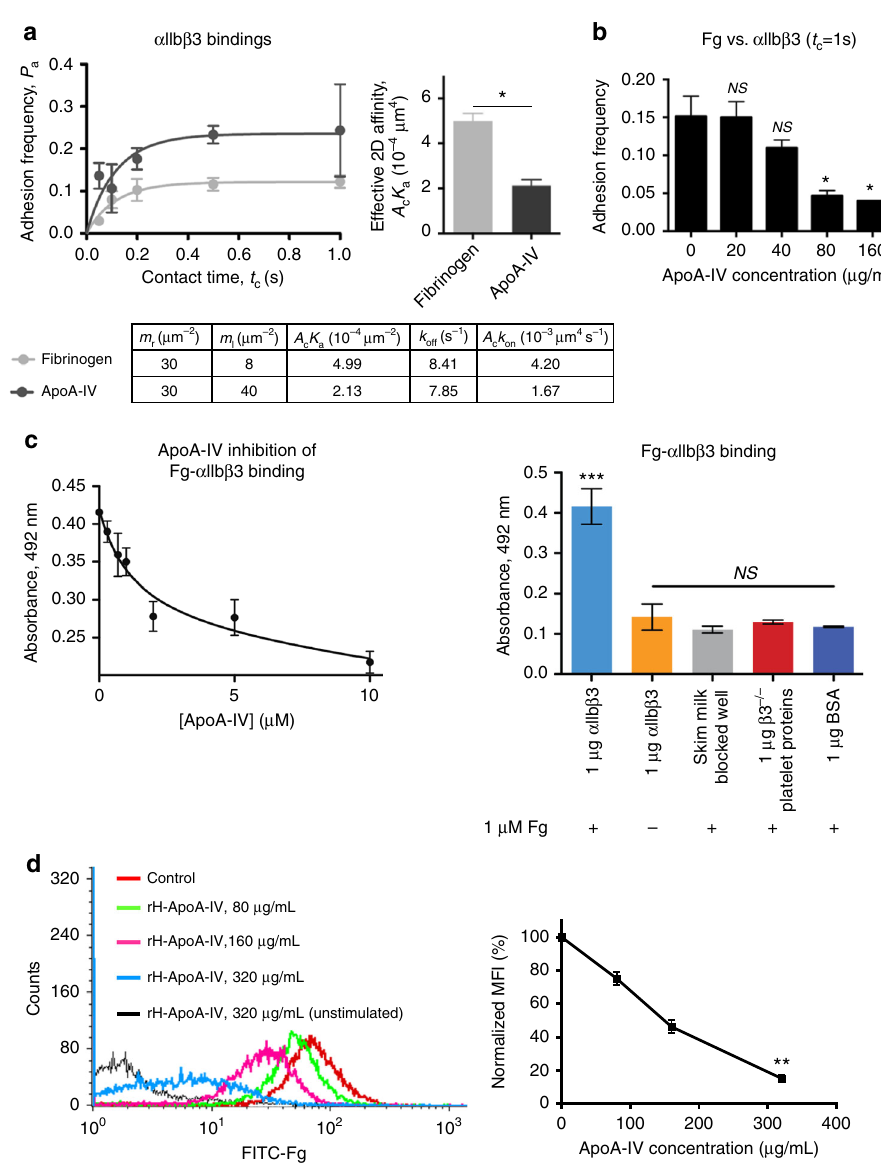
Fig. 2 ApoA-IV competes with Fg binding to α IIb β 3 integrin. a Effective 2D af fi nity of apoA-IV- α IIb β 3 versus Fg- α IIb β 3 within contact area. The adhesion frequency ( P a ) depends on the densities of receptor and ligand, therefore the weaker ligand apoA-IV required four-fold higher density (40 µ m − 2 ) than Fg (8 µ m − 2 ) yet only generated approximately one-fold higher P a . Af fi nity to α IIb β 3 for apoA-IV (2.13 × 10 − 4 μ m 4 ) is 43% of that for Fg (4.99 × 10 − 4 μ m 4 ) (Grey, Fg- α IIb β 3; dark grey, apoA-IV- α IIb β 3). b Dose-dependent inhibition of Fg- α IIb β 3 by recombinant apoA-IV in Biomembrane Force Probe assay. c , d Dose-dependent inhibition of Fg- α IIb β 3 by recombinant human apoA-IV in ELISA ( c ) and a fl ow cytometry assay ( d ). The inhibitory effect of varying apoA-IV concentrations (0 – 10 µ M) on the interaction between immobilized α IIb β 3 (1 µ g) and Fg (1 µ M) ( c , left). The concentration – response curves were fi t to the half maximal inhibitory model (methods) to determine the IC50 for apoA-IV. The apoA-IV IC50 for the inhibition of Fg- α IIb β 3 was found to be 1.32 ± 0.42 µ M. Control experiments con fi rm that the ELISA signal observed is indeed from speci fi c binding interactions and not from non-speci fi c or off-target binding ( c , right). FITC-conjugated human Fg binding to the human gel- fi ltered platelets that were incubated with increasing doses of human recombinant apoA-IV or BSA control was analyzed by fl ow cytometry ( d ). Platelets were activated by TRAP (250 µ M). P a adhesion frequency, A c contact area, m r α IIb β 3 density, m l Fg or apoA-IV density, k off 2D off-rate, A c k on 2D effective on-rate, rH-ApoA-IV recombinant human apoA-IV. n = 4. Unpaired, two-tailed Student ’ s t -test. Mean± SEM. NS not signi fi cant, * P < 0.05, ** P < 0.01 and *** P <